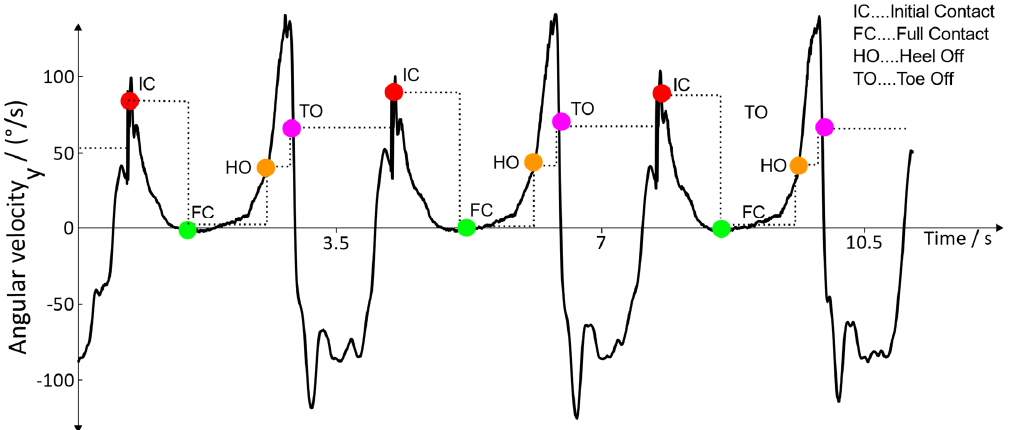
Figure 8. Detected gait cycle .